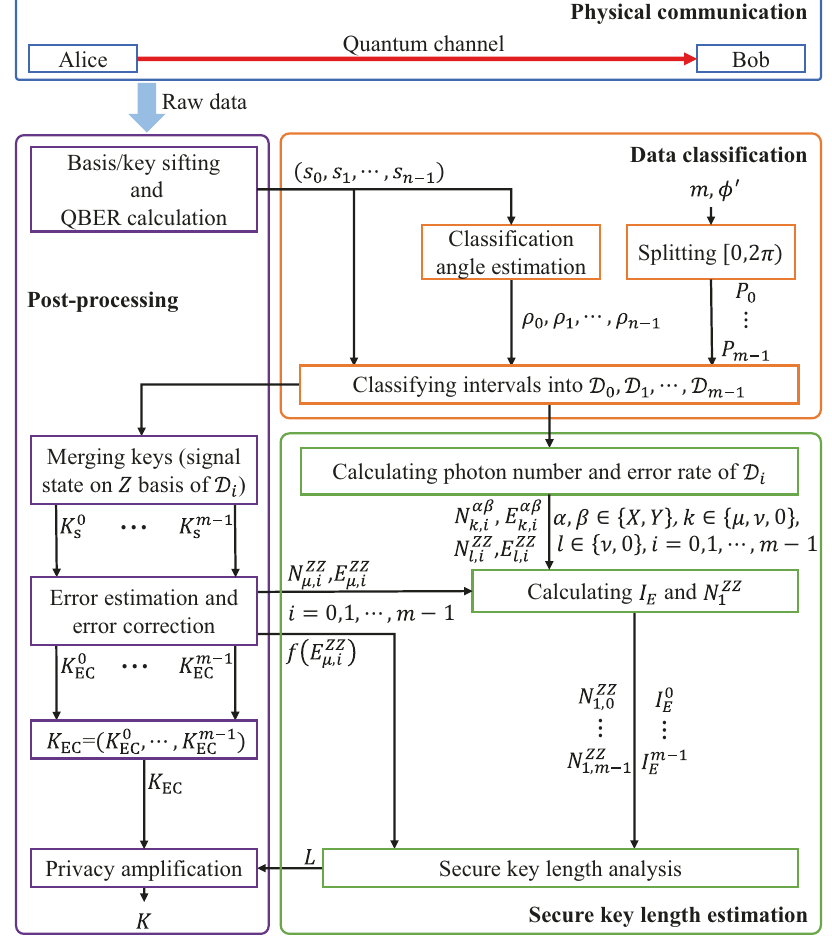
Fig. 1 The schematic diagram of the proposed free-running RFI QKD scheme. The scheme mainly contains four phases: physical communication, data classi fi cation, secure key length estimation and post-processing. Alice (Bob) prepares (measures) the quantum state, and generates raw data. Then, n interval sifted data s 0 , s 1 , … , s n − 1 are generated in the basis/sifting and quantum bit error rate (QBER) calculation procedure. Afterwards,